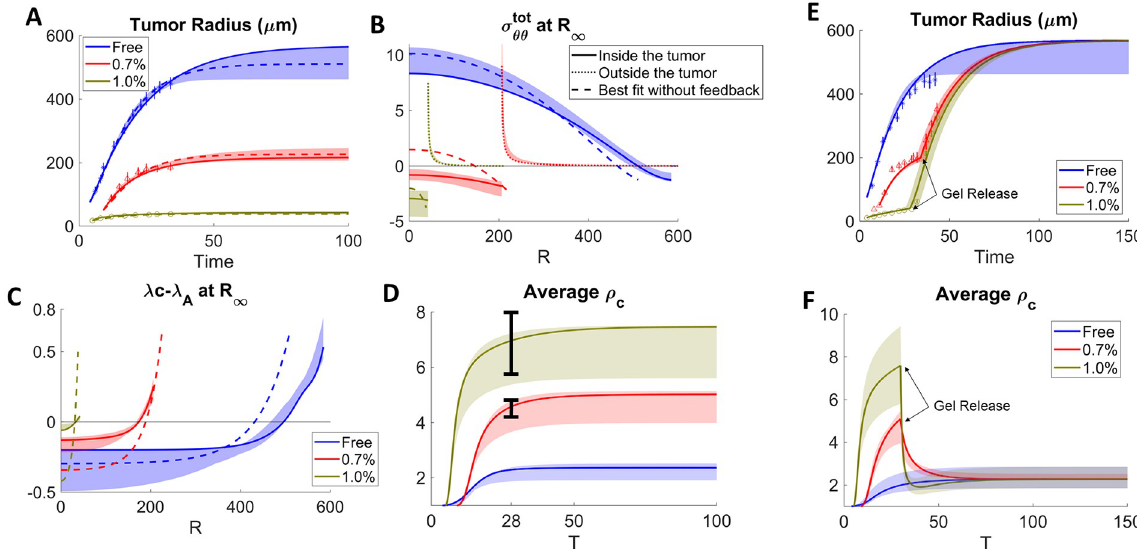
Fig 2. Fitting the model to data from [10] of tumor spheroids grown in free suspension (blue) and 0.7% (red) and 1.0% (brown) agarose gels with (solid) and without (dashed) feedback from the elastic stress (A) and when stresses are released by removing the gels in a narrow interval around the times reported in [10] (E). Bands show the results within 10% of the best fit with feedback in all panels. (B) and (C): The distributions of stresses and net volume growth rates from the model. (D) and (F): Average cell density of tumors in (A) and (E) respectively. The bars in (D) shows the experimental average density for 0.7% and 1.0% tumors, relative to the free tumor. See S2 Text for details.